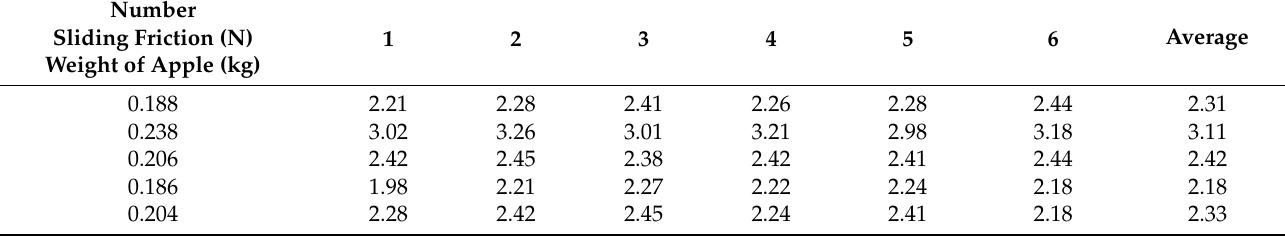
Table 2. Friction test of suction cup silicone material and Fuji apple surface.